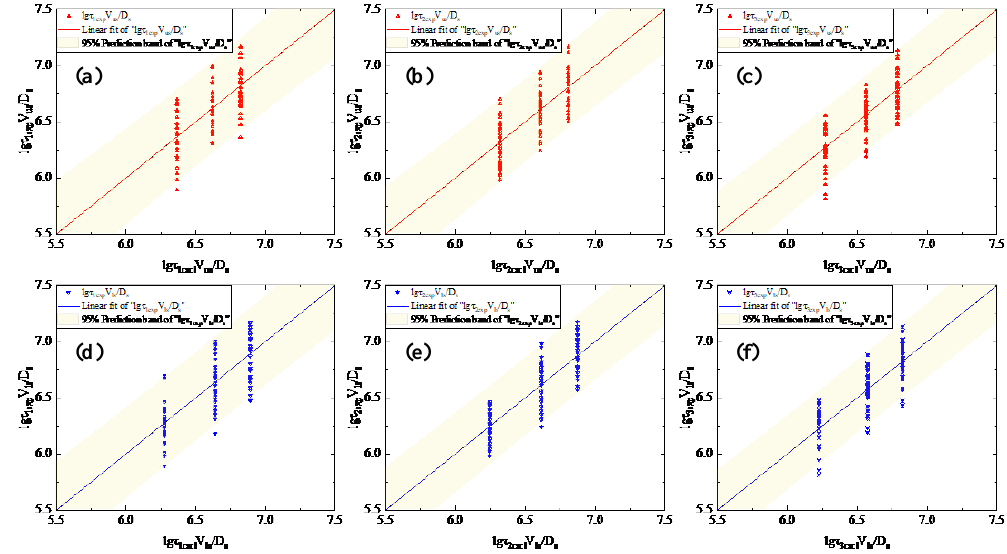
Figure 8. Comparison of experimental lg τ V s / D s with calculated ones for upper side nozzle ( a – c ) and lower side nozzle ( d – f ) respectively using τ 1 , τ 2 , τ 3